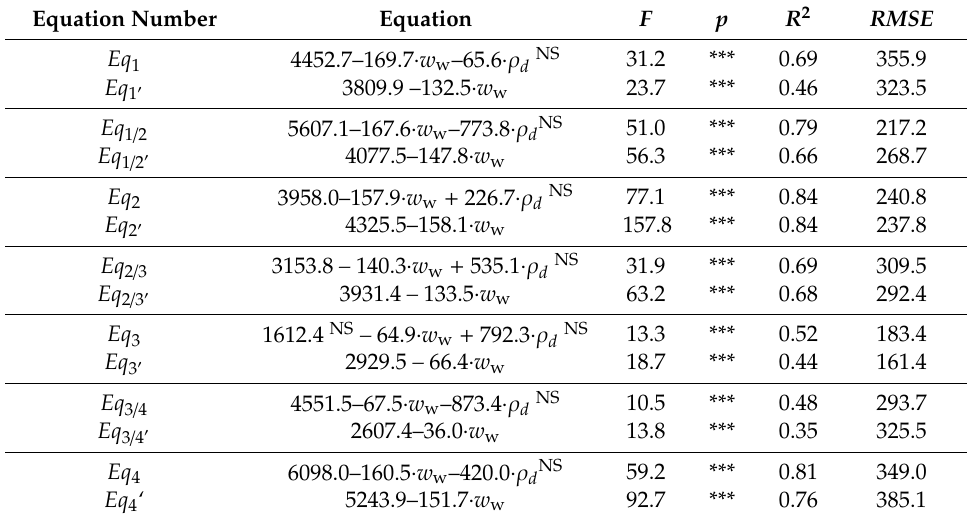
Table 7. Regression equations to calculate soil penetration resistance ( PR ) and their statistical